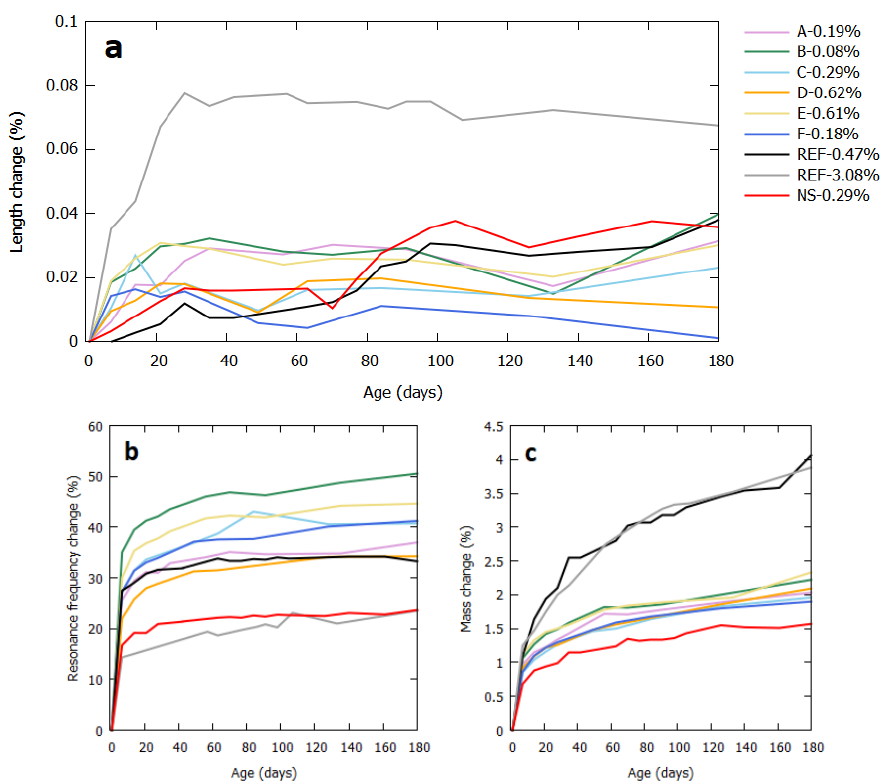
Figure 3. Six-month swelling behavior of the mortar samples, including their length change ( a ), resonance frequency change ( b ), and mass change ( c ).